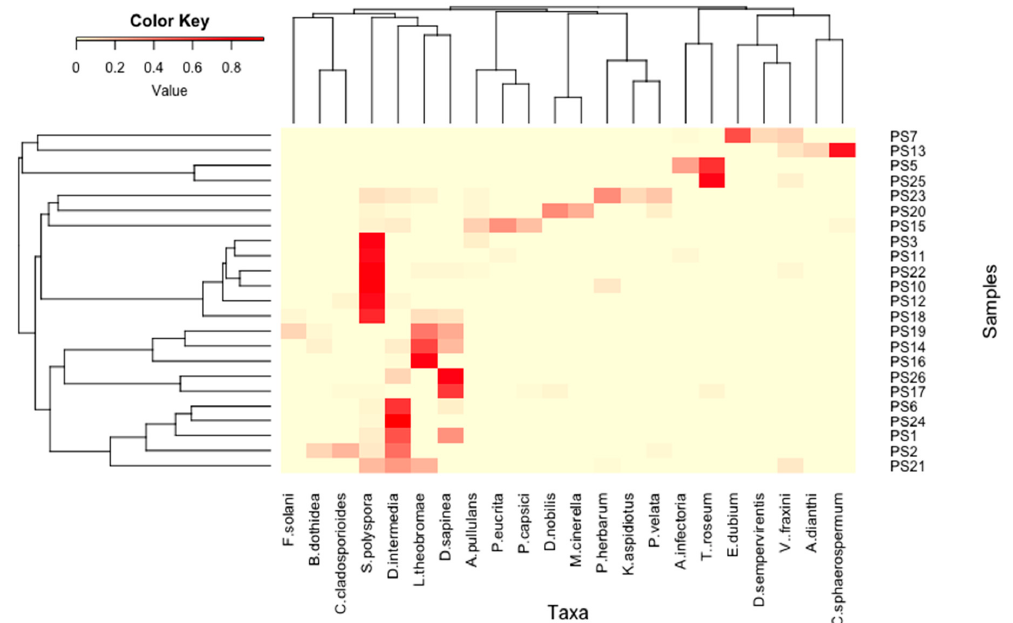
Figure 5. Heatmap analysis of identified pathogenic fungi that represented more than 10% of taxa detected in seed samples. Numbers indicate the samples of Pinus species seed (Table 1).